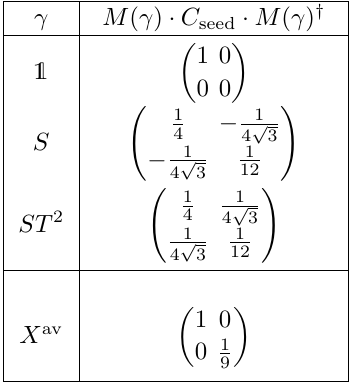
Table 1 . Orbit of the vacuum block for N = 3 ; k =